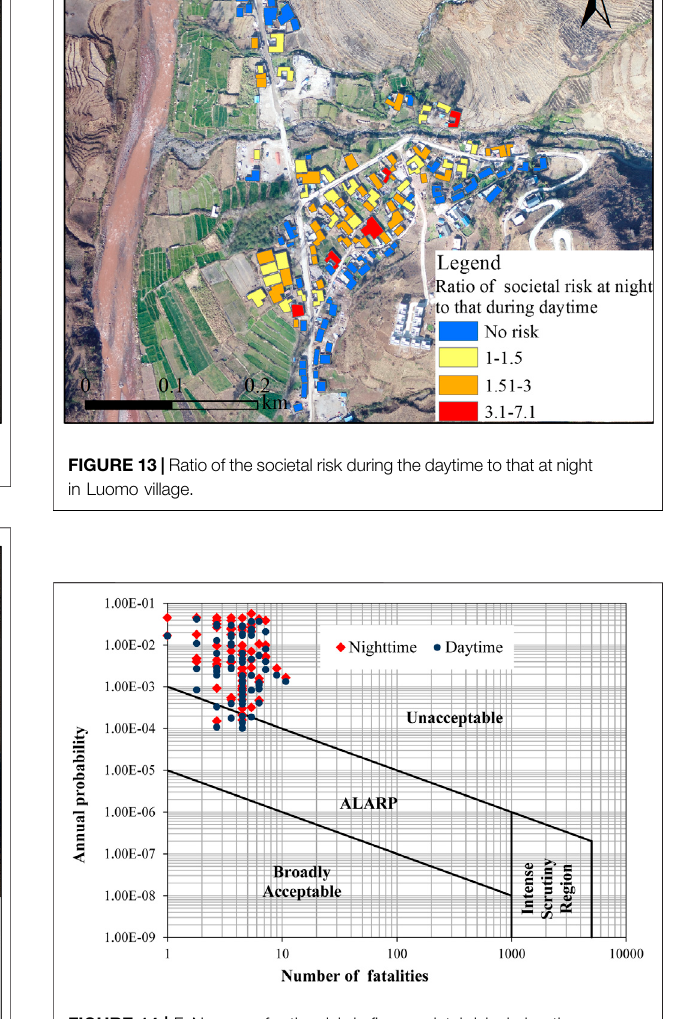
FIGURE 14 | F – N curves for the debris fl ow societal risk during the daytime and nighttime in Luomo village.